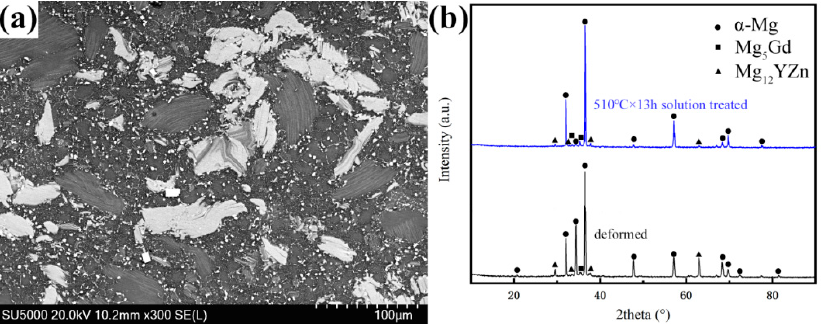
Figure 2. SEM photo and XRD results. ( a ) SEM photo of the deformed alloy. ( b ) XRD results of the deformed and 510 °C × 13 h solution-treated alloys.